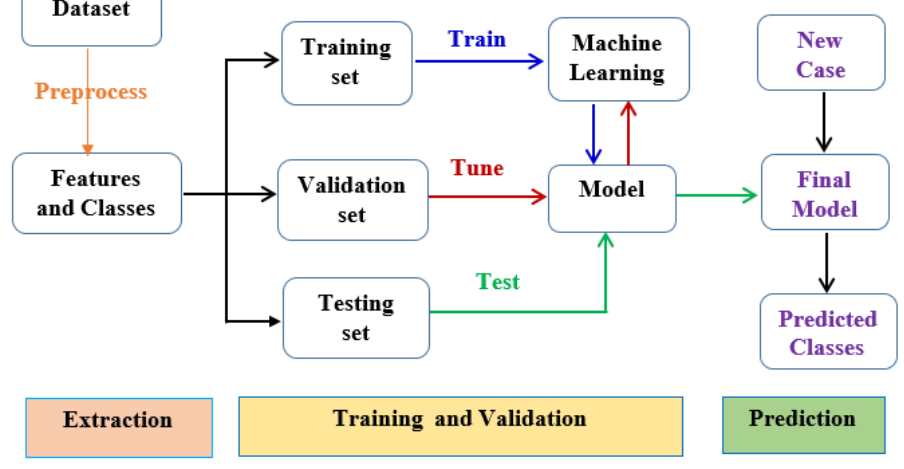
Figure 2. Experimental workflow of the predictive machine learning